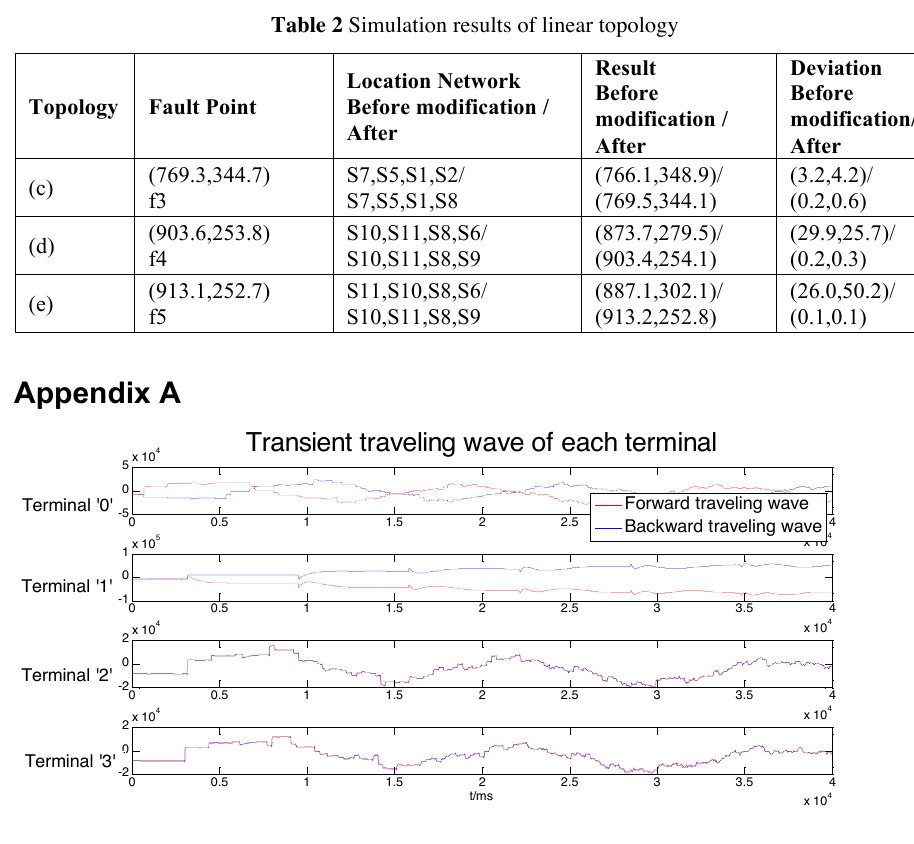
Fig. A1. Transient traveling wave of each